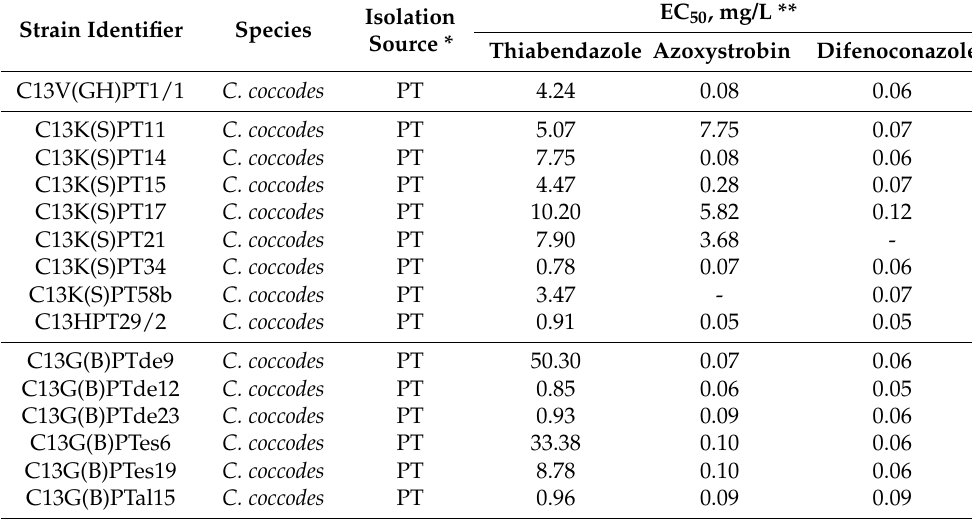
Table 5. Sensitivity to